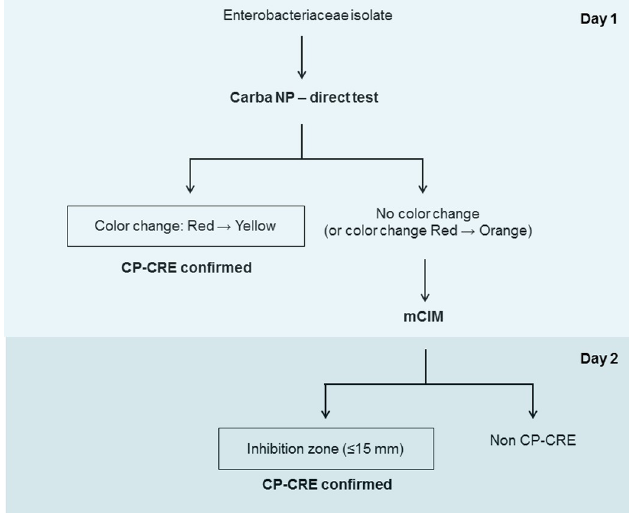
Fig 1. Proposed algorithm for rapid detection of CP-CRE in resource-limited